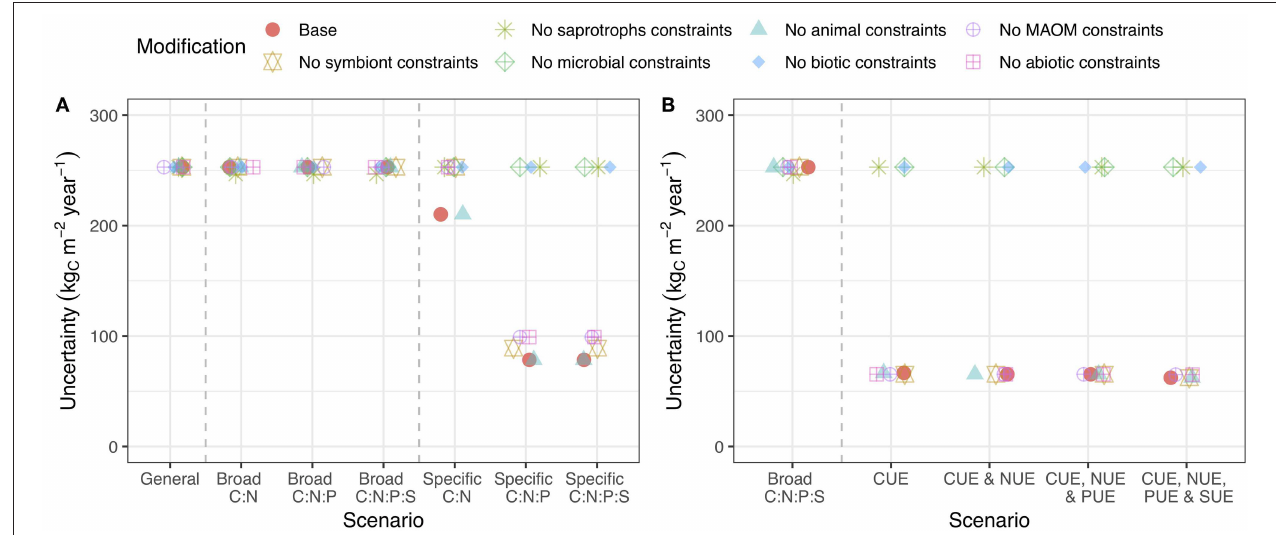
FIGURE 5 | Uncertainty in C cycling when stoichiometric and substrate use efficiency constraints are applied to all pools except the focal. Stoichiometric (A) or substrate use efficiency (B) information for the focal pool is most important when the line associated with that pool remains high on the graph. See caption for Figure 3 for a description of the axes. Versions of this plot for N, P, and S are presented in the supporting information ( Figure S4 ).